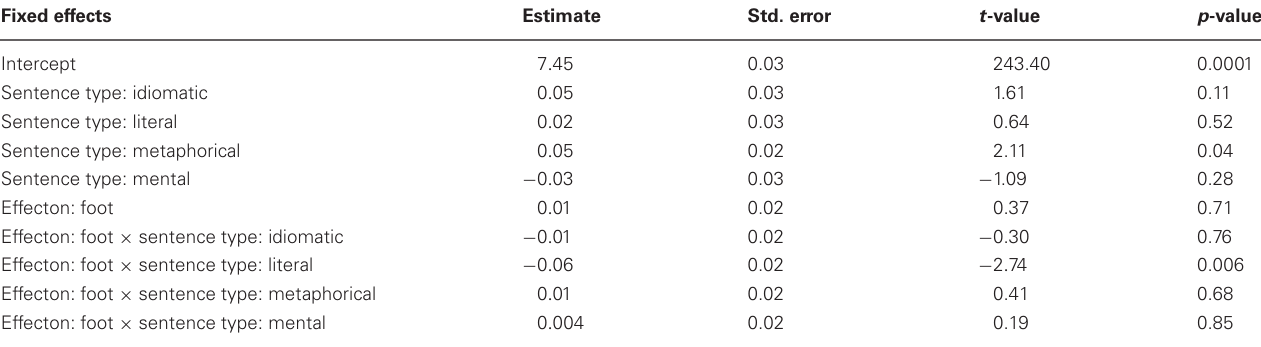
Table 2 | Fixed effects in the final model on correct response